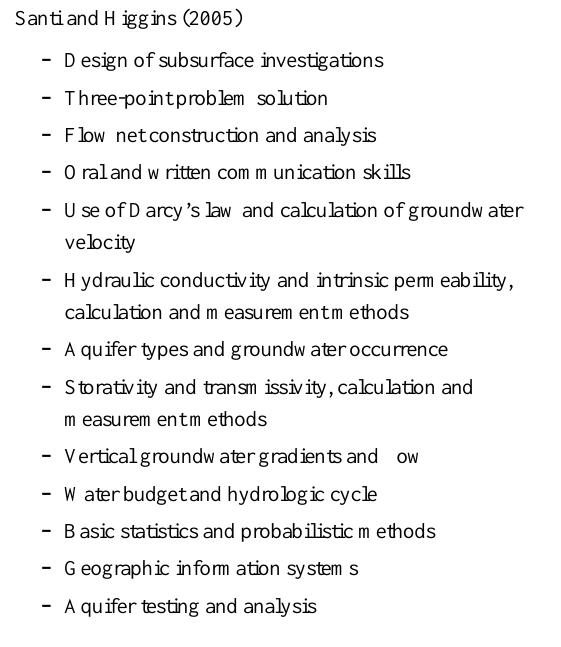
Table 1. Critical knowledge and skills for practicing hydrogeolo- gists.